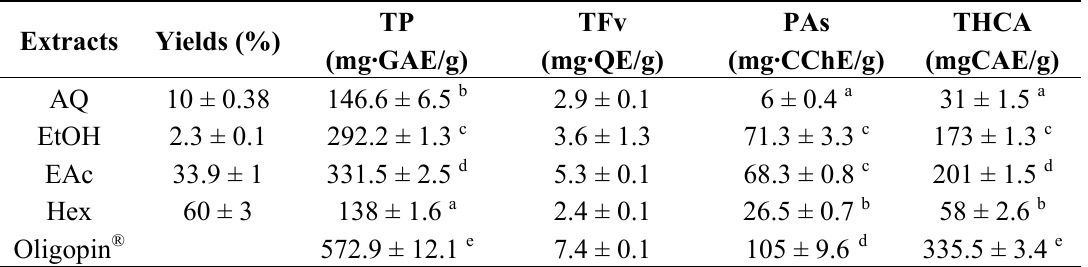
Table 1. Total phenols (TP), Total flavonoids (TFv), Proanthocyanidins (PAs) and Total hydroxycinnamic acids (THCA) of the extracts and ethanolic